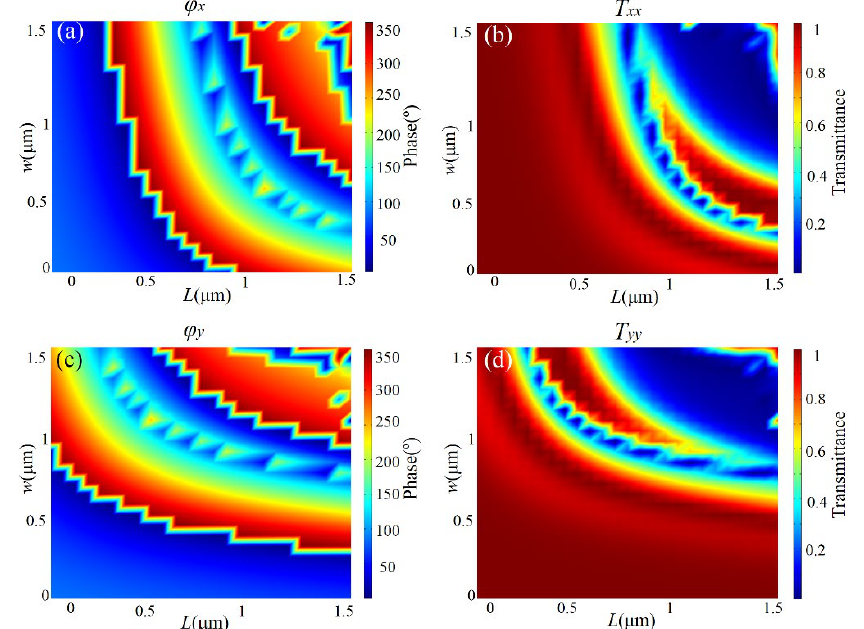
Figure 2. Transmitted phase ( a ) and normalized transmittance ( b ) as a function of L and w for normal incidence of the X -polarized light respectively, for the GaAs nano-bricks on CaF 2 substrate. ( c , d ) Transmitted phase and normalized transmittance as a function of L and w for normal incidence of the Y -polarized light, respectively.